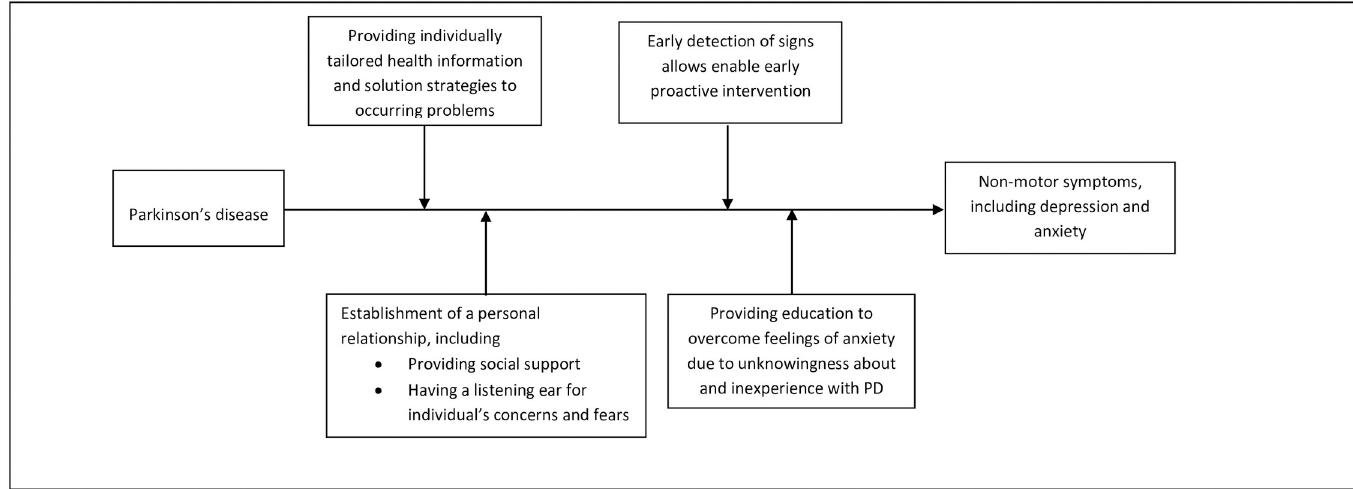
Fig 4. Mediators of the effect of case management on reduction of depressive symptoms and feelings of anxiety: Hypothetical framework informed by this meta- analysis.